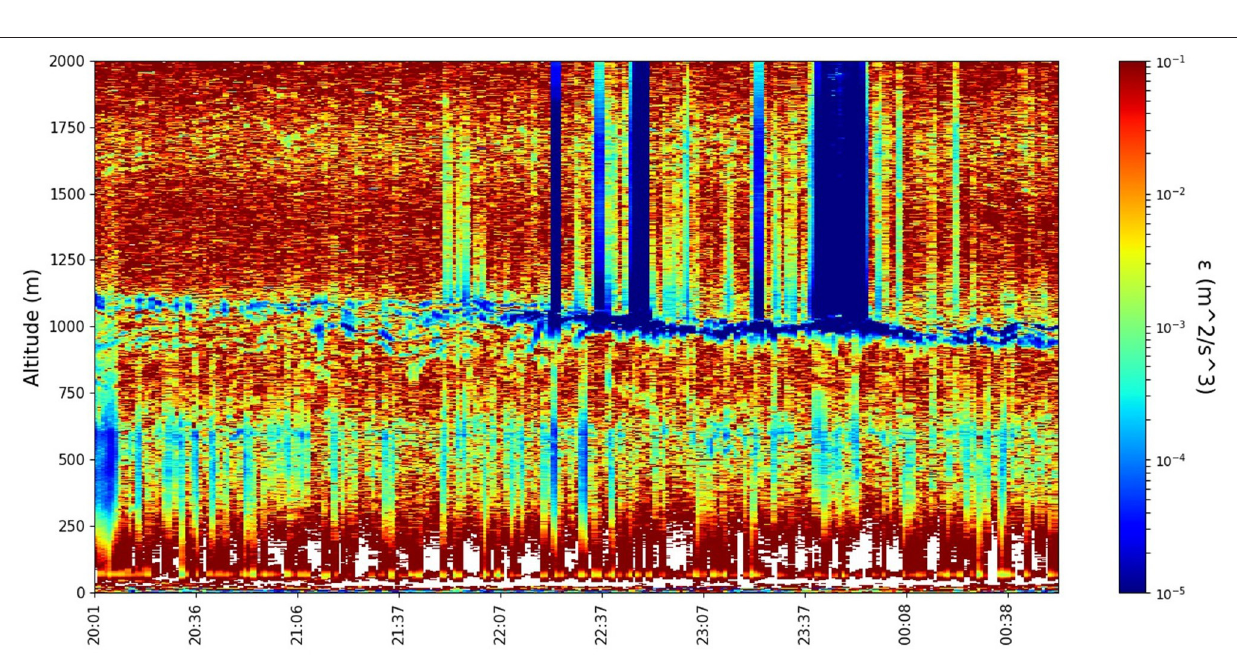
for obtaining the injection and dissipation scale profiles is reliant on calculating the scintillation profiles of the lidar signal by observing the variation between multiple RCS profiles (Rosu et al.,